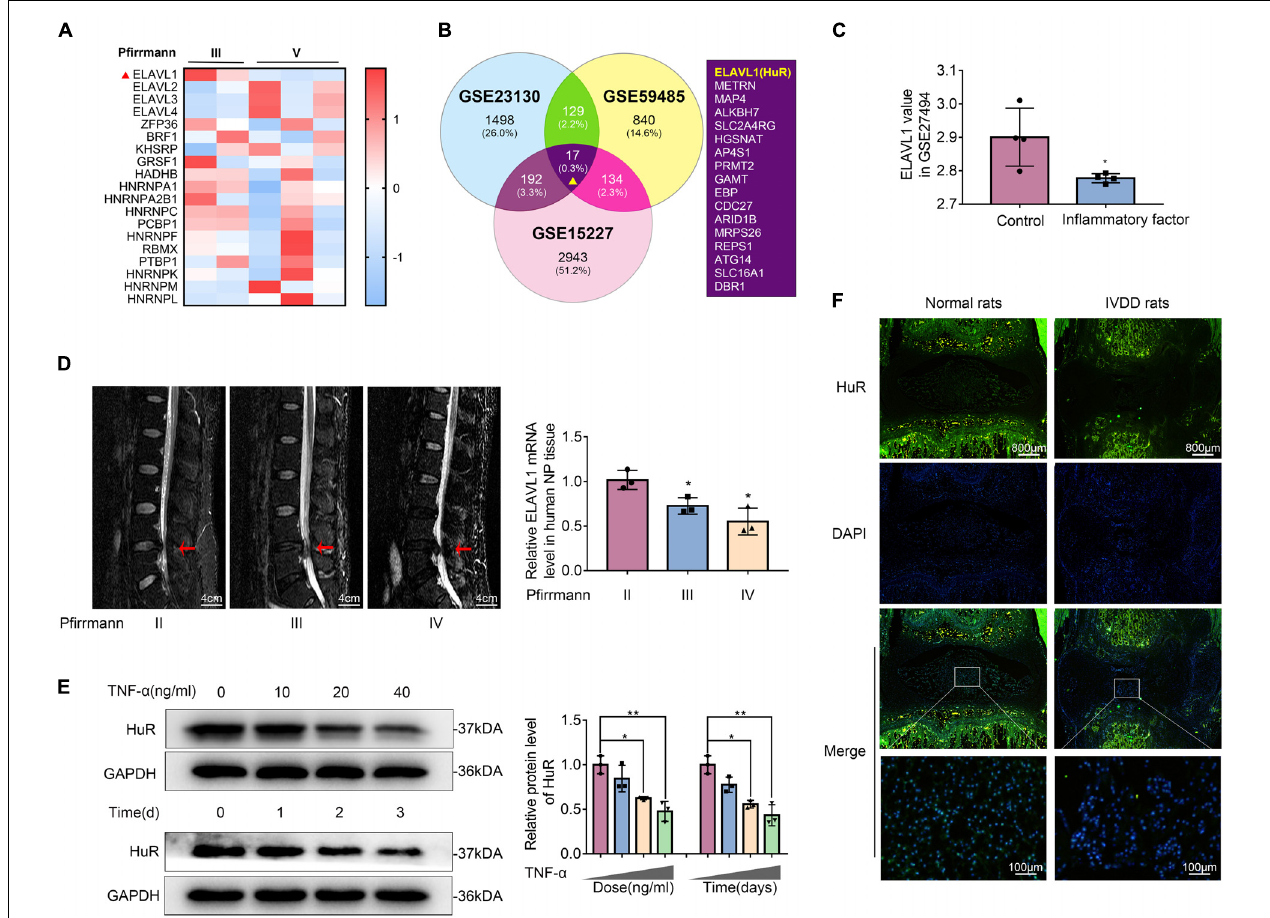
FIGURE 1 | The expression of HuR is decreased in degenerative NP tissues and TNF- α -treated NP cells. (A) The heatmap, from GSE23130, displayed the expressions of 19 known post-transcriptional genes. (B) Venn diagram of all differentially downregulated genes ( p < 0.05, FC < 0) and data from different NP tissues (GSE23130, GSE59485, and GSE15227). (C) The ELAVL1 gene expression from GSE27494 in NP cells under inflammatory factor stimulation. (D) Representative MRI images of three different degrees of IVDD patients, and the ElAVL1 gene expression of NP tissue (The red arrow indicates the intervertebral disc segment used in the experiment). (E) The ELAVL1 protein expression was detected by Western blot in various concentrations or time of TNF- α -treated NP cells. (F) Representative immunofluorescence staining of HuR in NP tissue from normal and IVDD rats (scale bar: 800 µ m). All data were shown as mean ± SD. * p < 0.05, ** p <